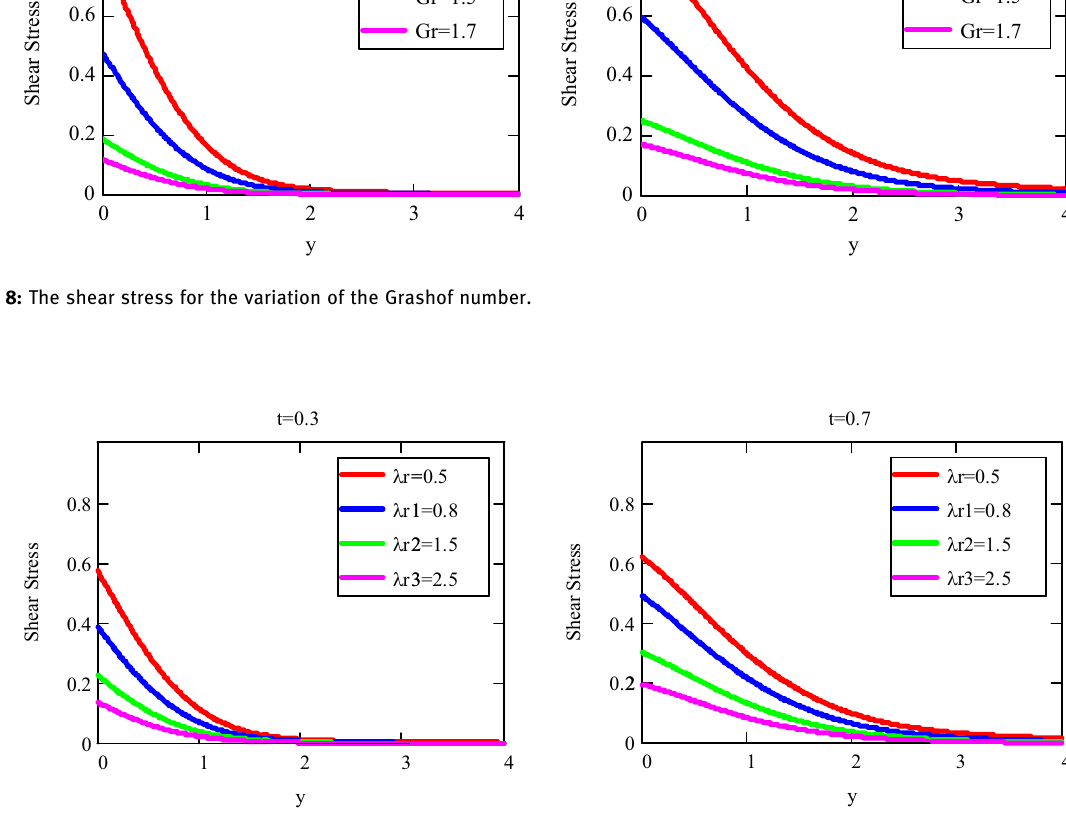
Figure 9: The shear stress for various estimations of retardation time.